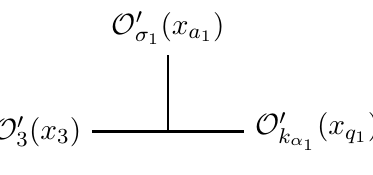
Figure 13 . The OPE vertex containing O 0